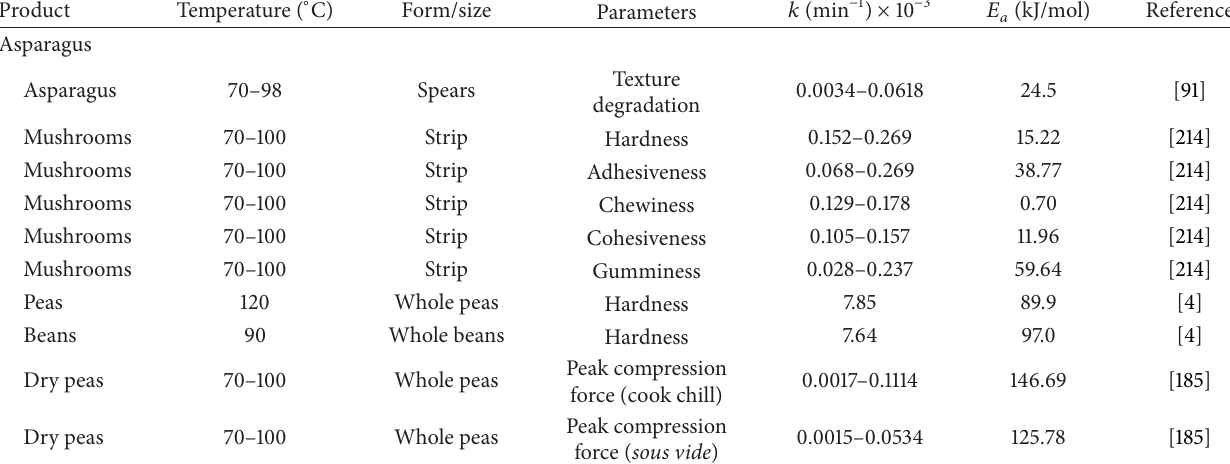
Table 6: Kinetic parameters associated with texture degradation in asparagus, peas, beans, and dry